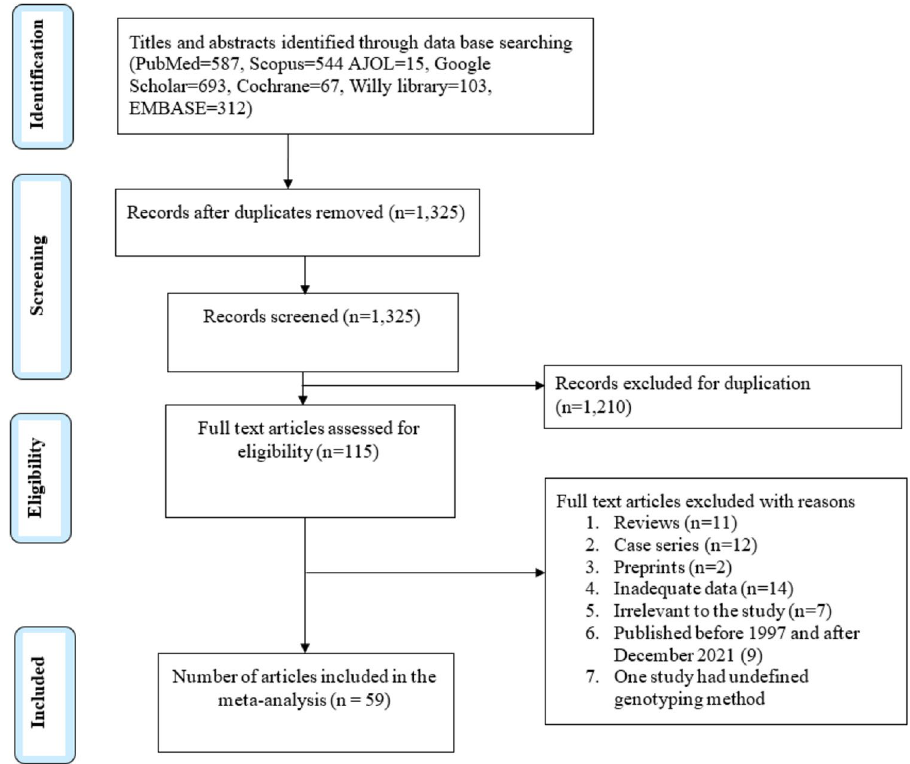
Figure 2. Flow chart for study eligibility following PRISMA